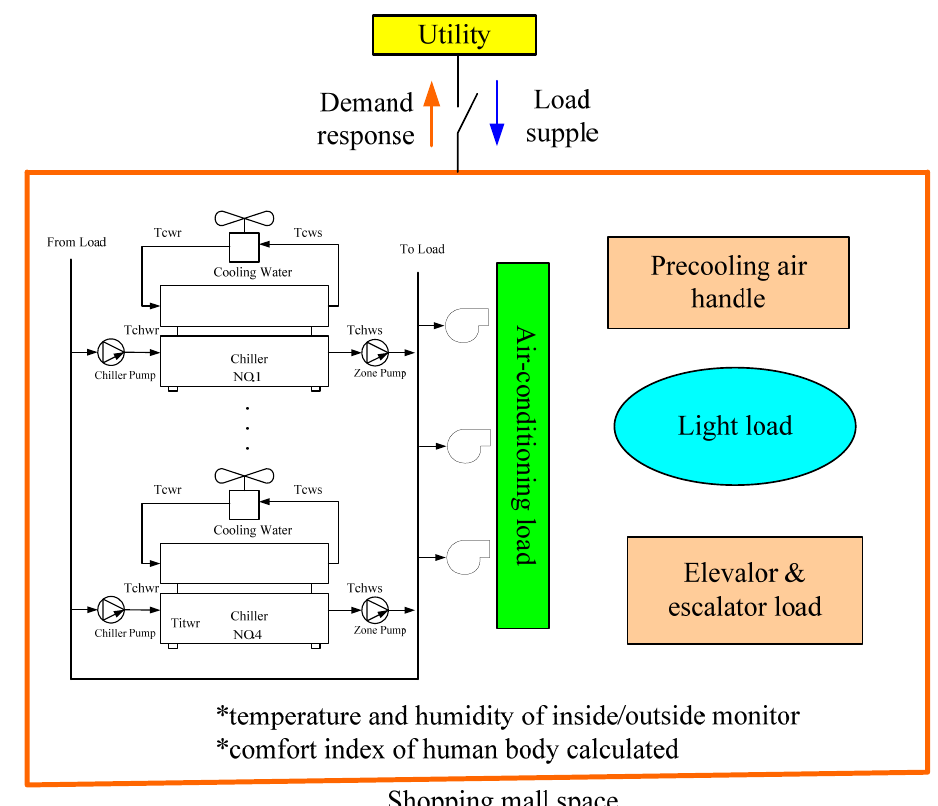
Figure 1. The system architecture studied in this paper.